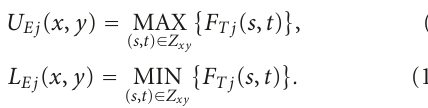
Figure 3: For data matrix of Figure 1(a): (a) upper envelope matrix using FABEMD before smoothing, (b) lower envelope matrix using FABEMD before